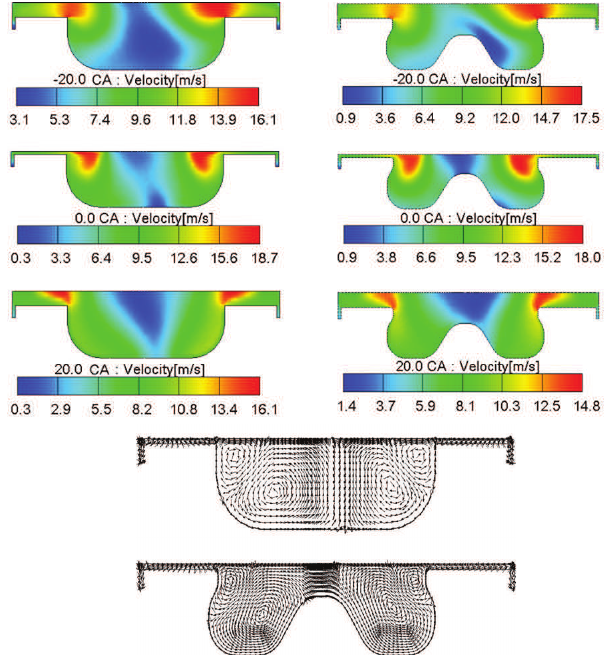
Fig. 12. Distribution of flow speed in the piston central section and vectors of speed in the piston central section at TDC